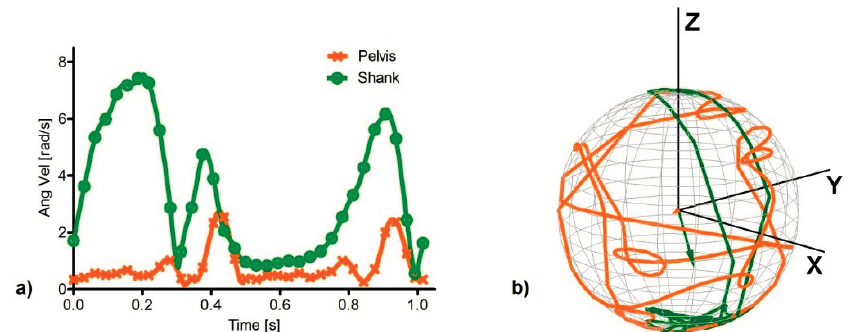
Figure 2. Magnitude ( a ) and direction ( b ) of the angular velocity vector associated to the pelvis (orange) and shank (green) gyroscopes during a stride; The orange and green arrows ( b ) represent the position of the centroids for the trajectory followed by the unit vector describing the direction of the angular velocity of pelvis and shank,